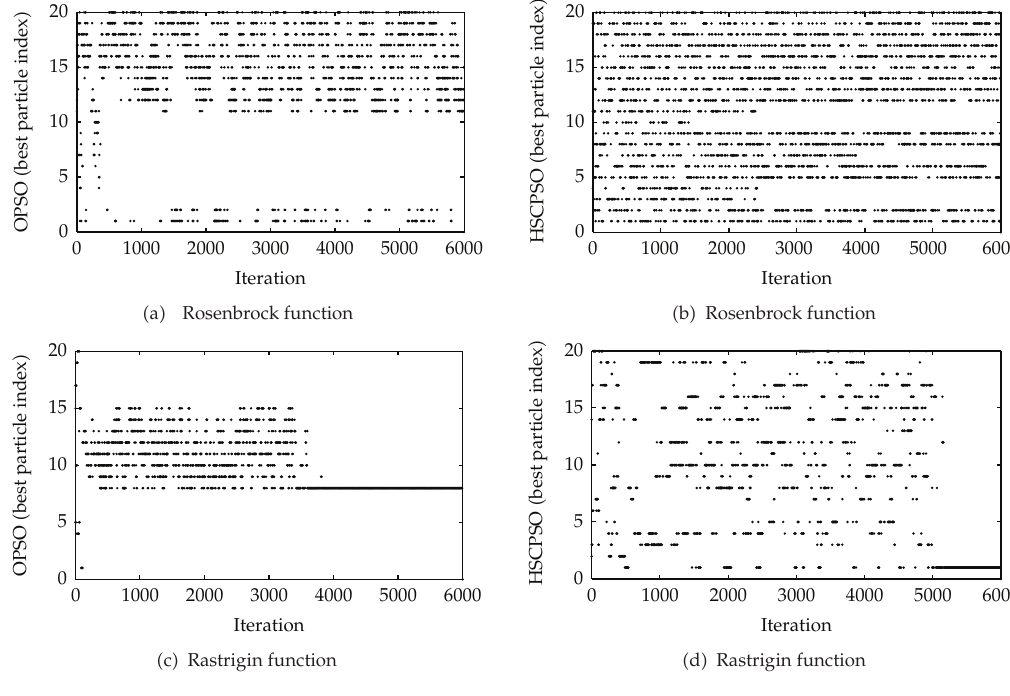
Figure 8: The best particle in the swarm with iteration